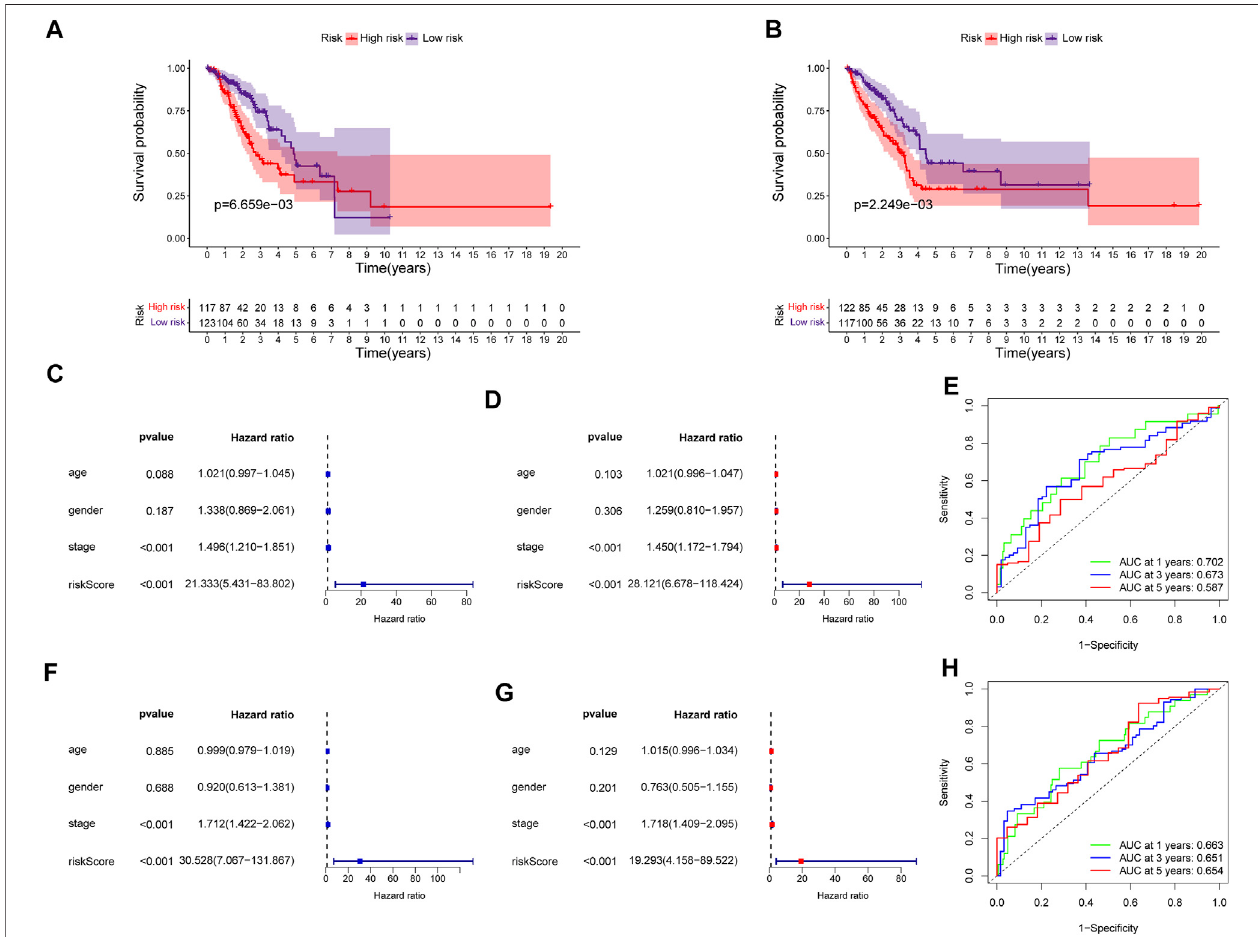
FIGURE4| ValidationoftheprognosticsignatureinthetwosubsetsoftheTCGAcohort (A) Kaplan – Meiersurvivalcurveofthehigh-andlow-riskgroupsinsubset one of the TCGA cohort (B) Kaplan – Meier survival curve of the high- and low-risk groups in subset two of the TCGA cohort (C) Univariate Cox regression analysis of clinicopathologicalvariablesandECMRSinsubsetoneoftheTCGAcohort (D) MultivariateCoxregressionanalysisofclinicopathologicalvariablesandECMRSinsubset one of the TCGA cohort (E) ROC curves of one-, three- and fi ve- years in subset one of the TCGA cohort indicating the predictive ability of ECMRS (F) Univariate Cox regression analysis of ECMRS and clinicopathological variables in subset two of the TCGA cohort (G) Multivariate Cox regression analysis of ECMRS and clinicopathological variables in subset two of the TCGA cohort (H) ROC curves of one-, three- and fi ve- years in subset two of the TCGA cohort indicating the predictive ability of ECMRS. TCGA = The Cancer Genome Atlas; GEO = Gene Expression Omnibus; ECMRS = extracellular matrix-related score.